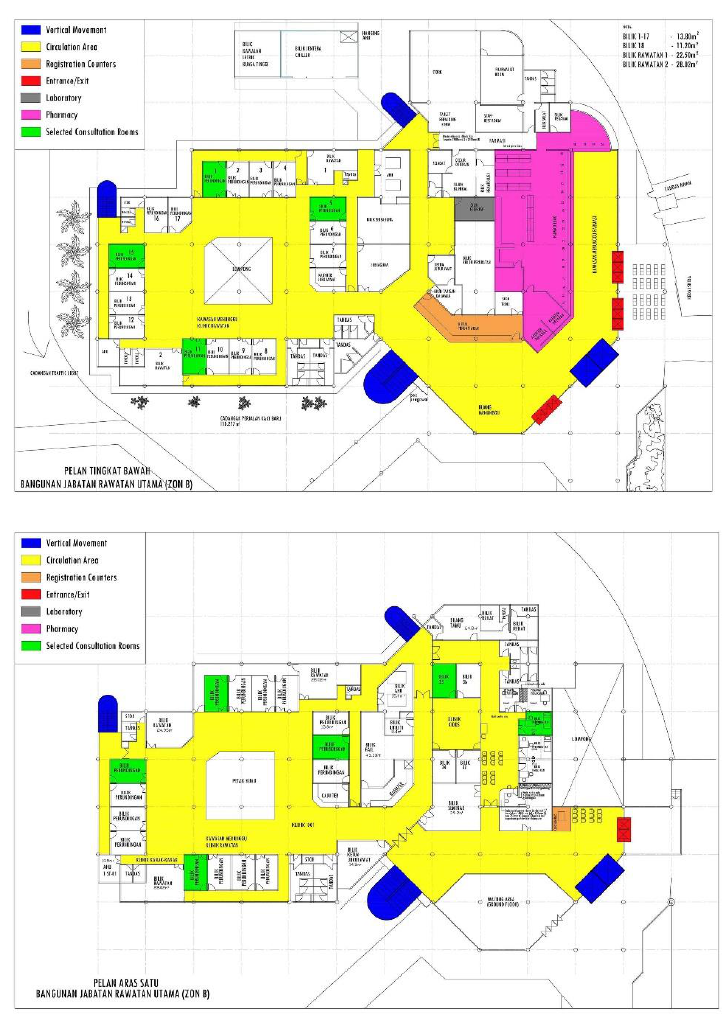
Figure 4. The selected zones and functions in the virtual experiment are highlighted.